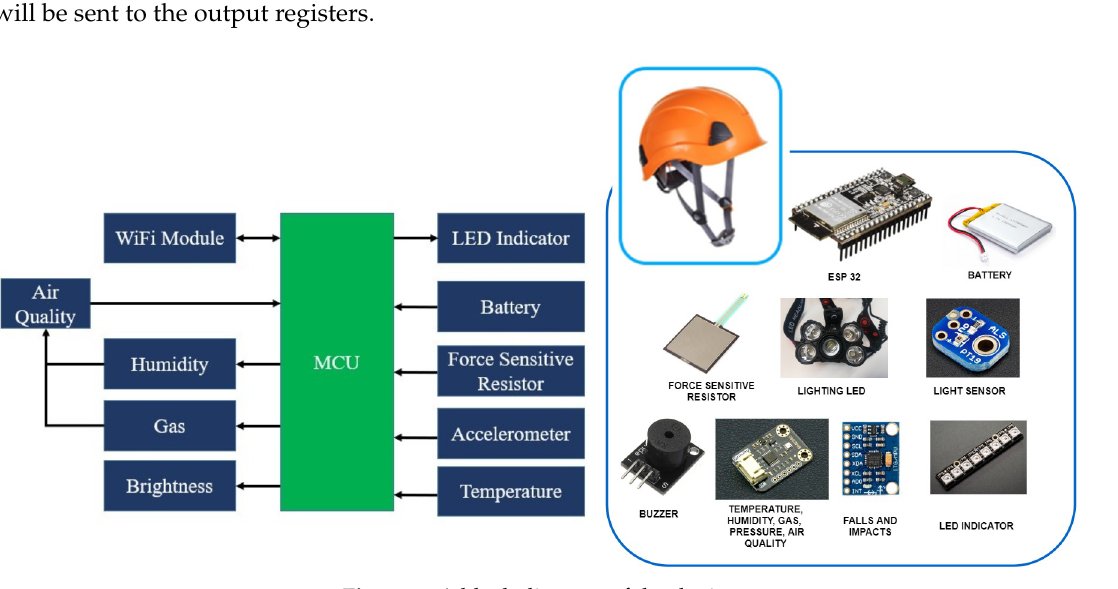
Figure 2. A block diagram of the